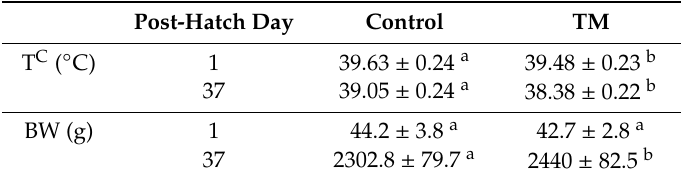
Table 2. E ff ects of embryonic thermal manipulation (TM) on post-hatch body weight (BW) and cloacal temperature (T C ) of broiler chickens.